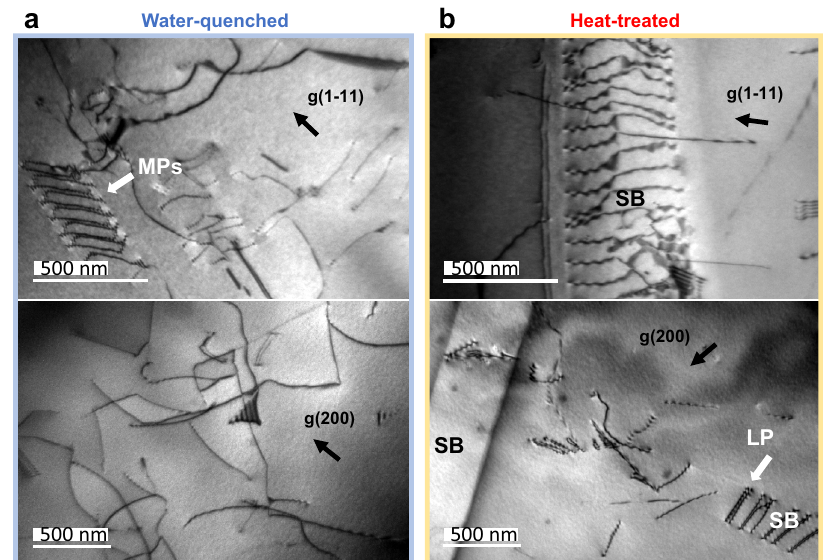
Fig. 7 | Alteration of dislocation-slip behaviors by short-range ordering. Che- mical short-range ordering is observed in both samples with the L1 2 type dom- inantly found in Sample HT. a Two-beam bright- fi eld images of Sample WQ shows